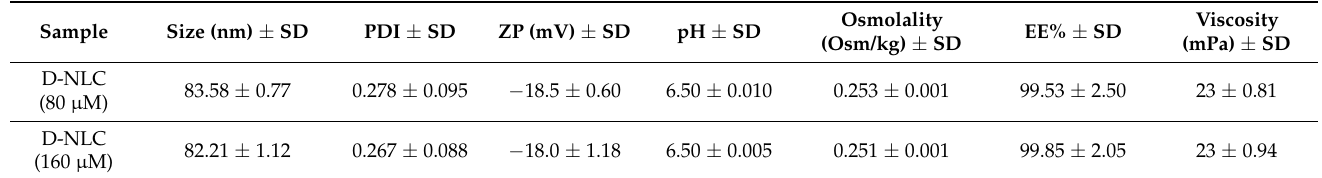
Table 5. Technological characterization of D-NLCs at 80 µM and 160 µM.